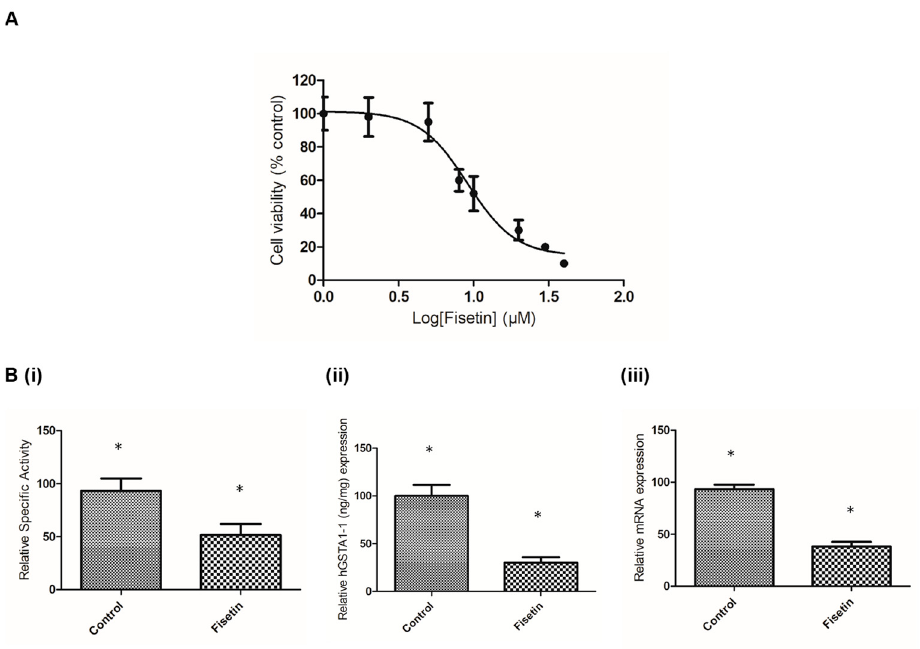
Figure 6. ( A ) Effect of fisetin concentration on the viability of proliferating CaCo-2 cells after a 24 h treatment. Cell viability was assayed using the neutral red uptake assay. Data are presented as a percentage of the respective control (=100%). Results are presented as the mean ± S.D. of 3 independent experiments. ( B ) Relative enzyme-specific activity ( i ) and accumulation of hGSTA gene transcripts ( ii ) under fisetin (1 µ M) treatment in proliferating CaCo-2 cells after 24 h. Total RNA was isolated, reverse transcribed to cDNA and subjected to real-time quantitative PCR using gene-specific primers. Relative mRNA level was calculated with respect to the respective expression level in the control samples after normalization with the levels of the glyceraldehyde 3-phosphate dehydrogenase (GAPDH) and beta-2 microglobulin (B2M) transcripts. Results are presented as the mean ± SD of 3 independent experiments. The asterisks indicate statistical significance at the 0.05 level.